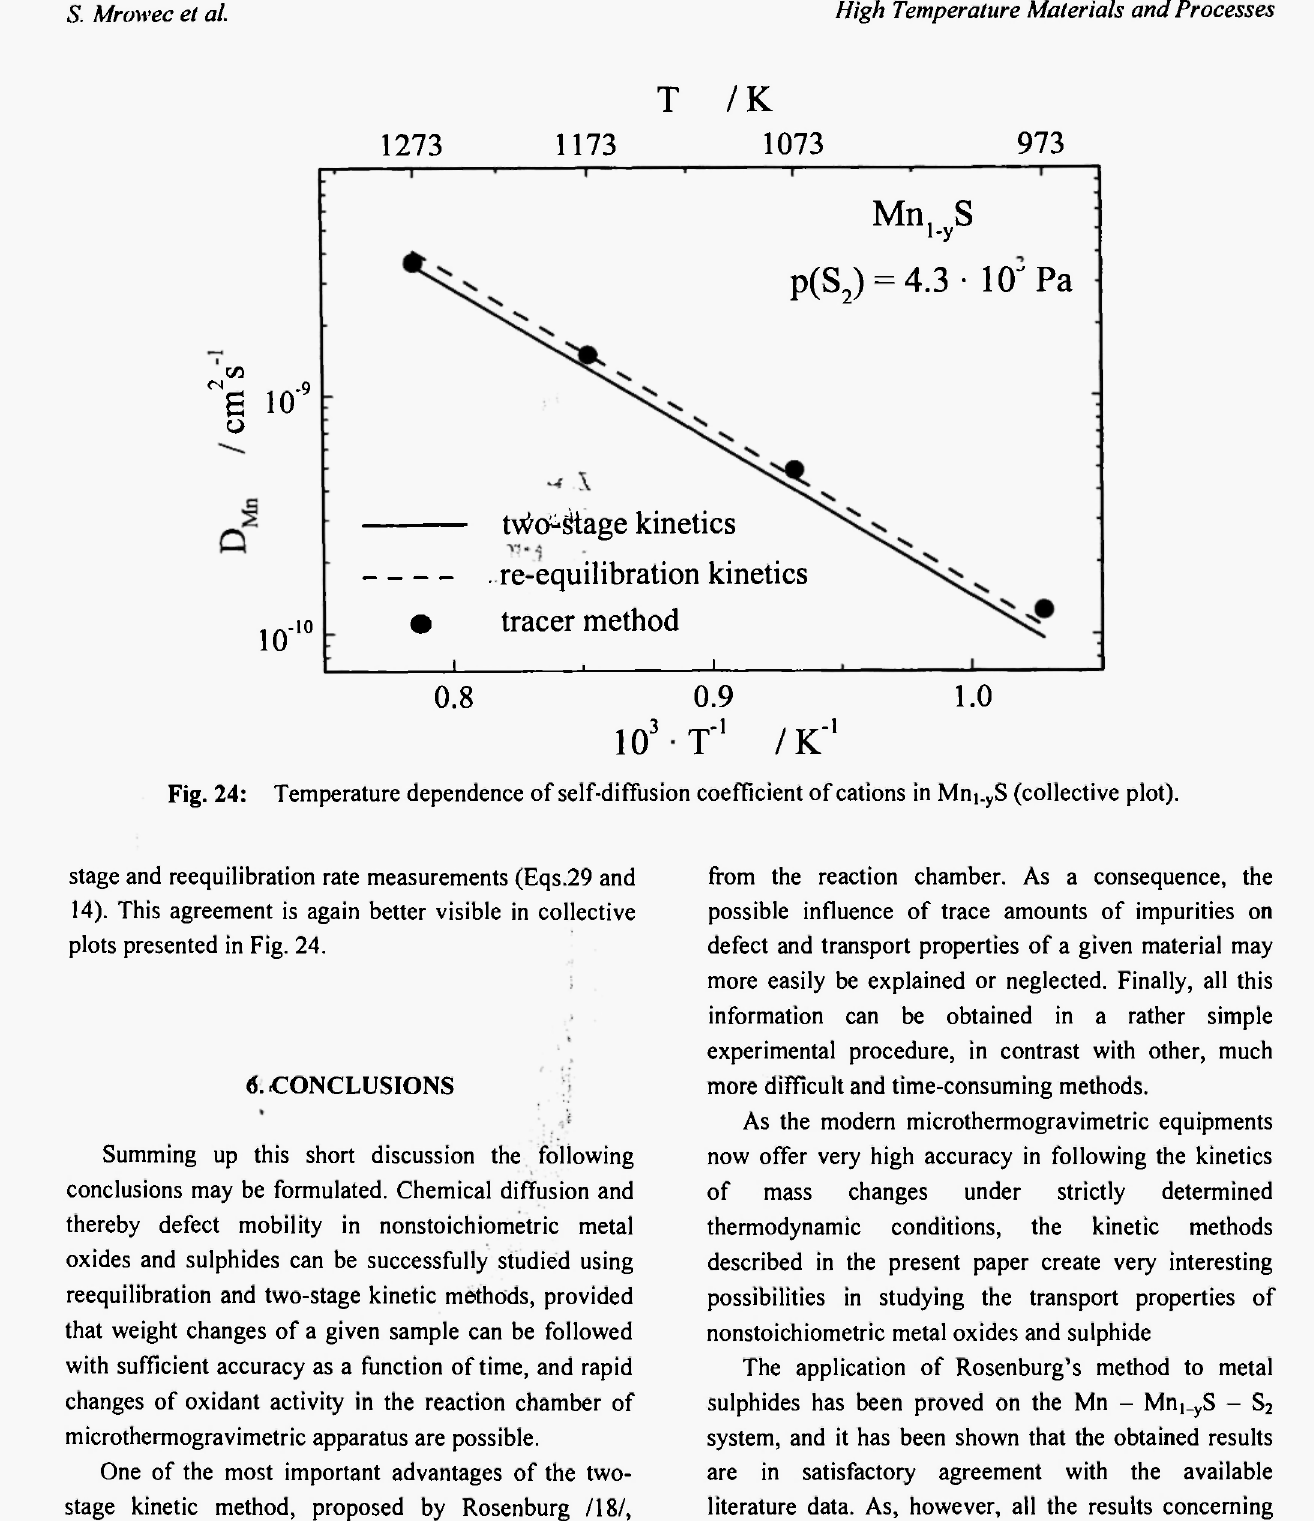
Fig. 24: Temperature dependence of self-diffusion coefficient of cations in Mnj. y S (collective plot).